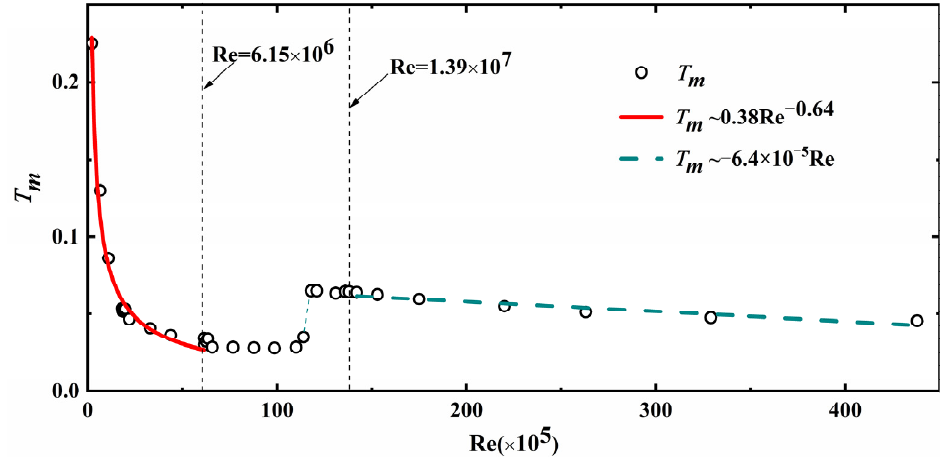
Figure 9. The average temperature in the middle region of the two heat sources varies with Re.